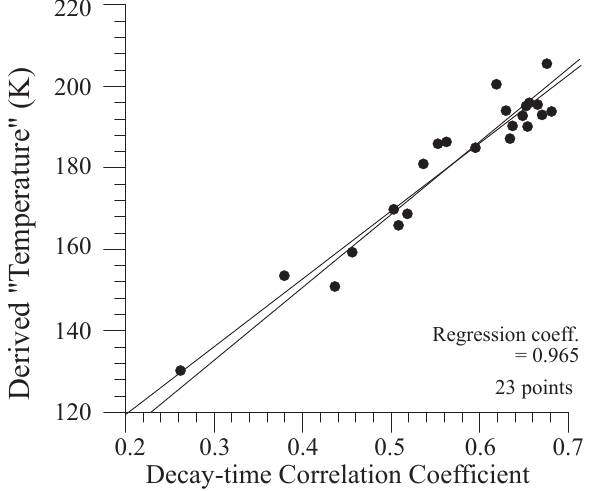
Fig. 5. Graph showing the impact of poor phase calibration on tem- Fig. 5. peratures deduced with an interferometric meteor radar. It has been assumed that the temperature is deduced by the “slope method” (Hocking, 1999). Poor phase calibration leads to reduced corre- lation coefficients, which, in turn, produces artificially low temper-